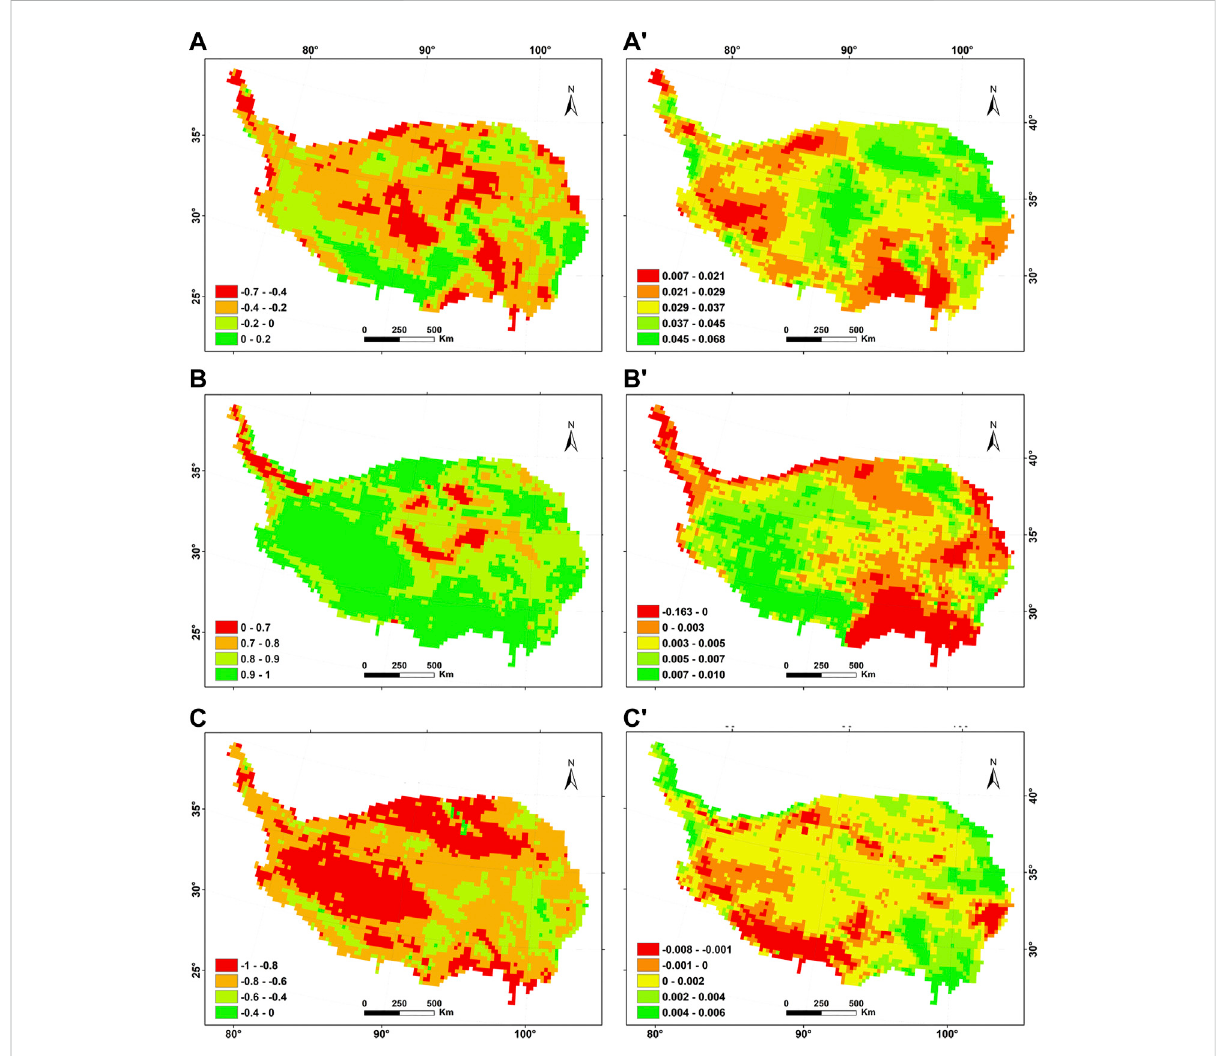
FIGURE 9 Correlation analysis of T, P and PET with SPEI (A – C) and their trend analysis (A ’– C ’ )